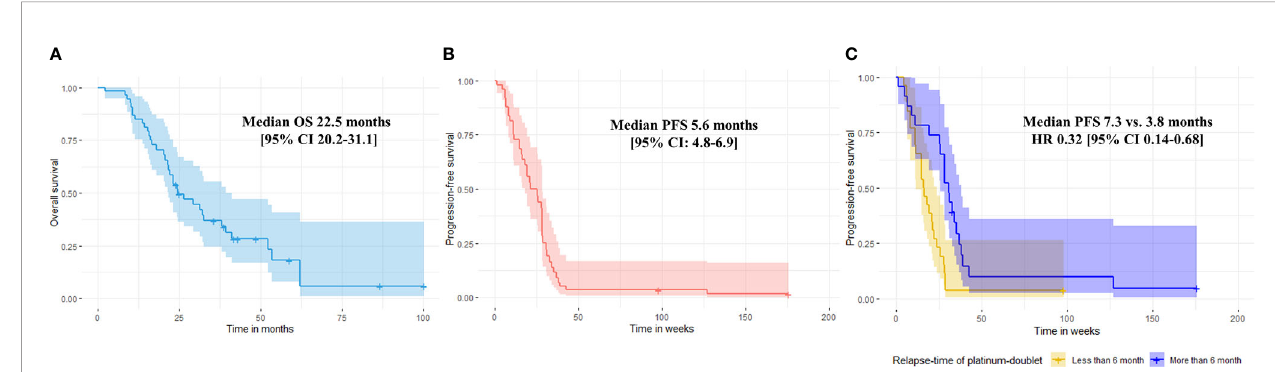
FIGURE 1 | Median overall survival (A) and median progression-free survival of combination docetaxel/nintedanib of the entire population (B) . Progression-free survival of combination docetaxel and nintedanib according to relapse-time of platinum-doublet chemotherapy. Median PFS were 7.3 months vs. 3.8 months for relapse-time of platinum doublet chemotherapy ≥ 6 months vs. < 6 months, respectively (multivariate HR 0.32 [95% CI: 0.14-0.68], p -value 0.003) (C)